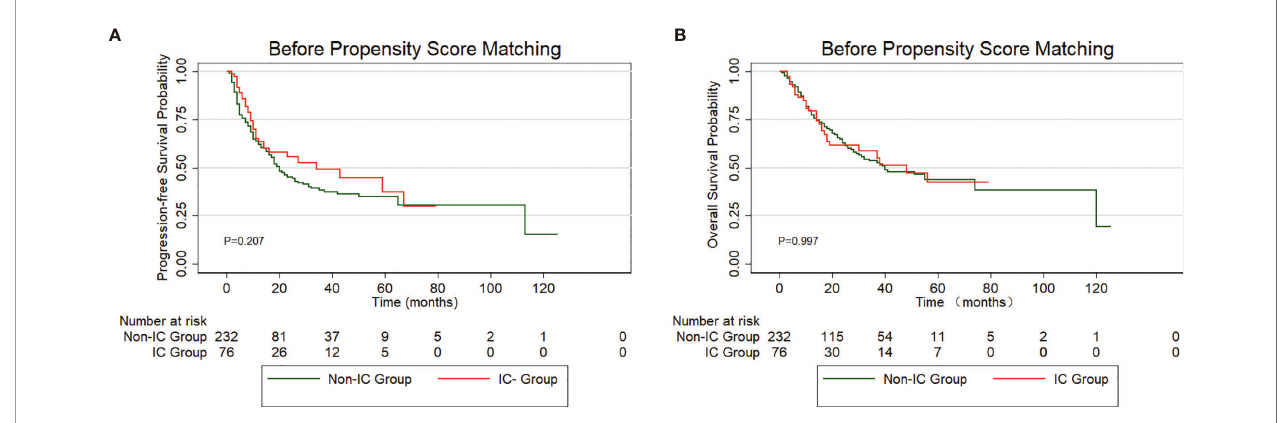
FIGURE 5 | PFS (A) and OS (B) curve for patients treated with induction chemotherapy (IC) versus non-IC in low-risk group before propensity score matching